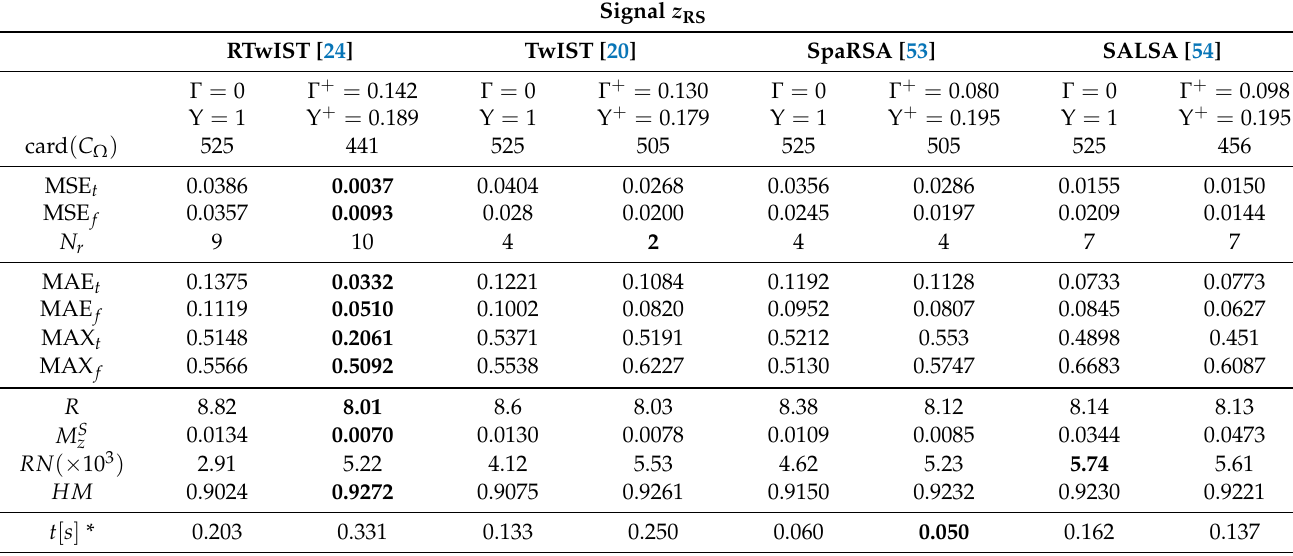
Table 3. Performance of the state-of-the-art reconstruction algorithms with the full N (cid:48) τ × N (cid:48) ν area ( ( Γ , Υ ) = ( 0,1 ) ) versus the proposed CS-AF area selection ( Γ + , Υ + )